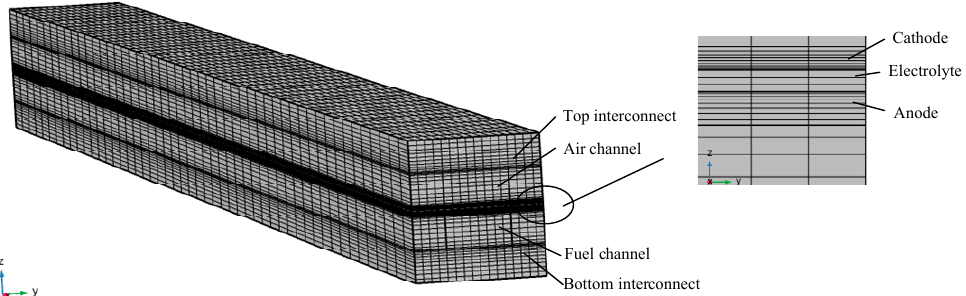
Figure 1. Three-dimensional model for the planar SOFC.